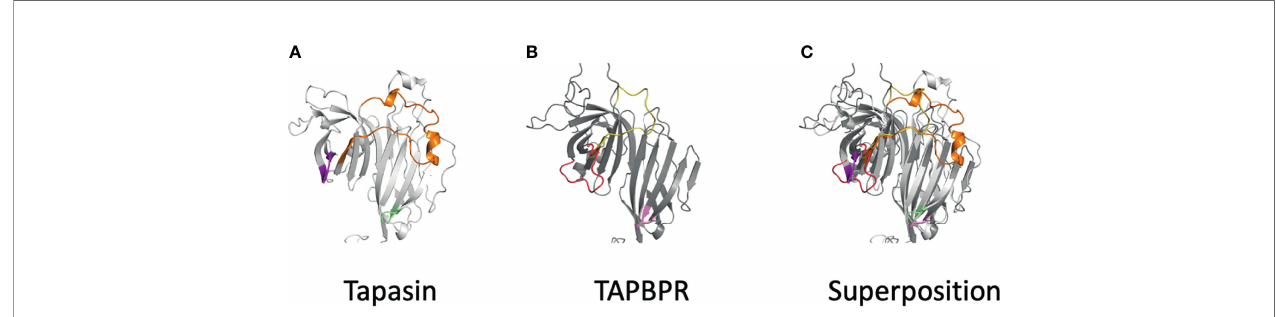
FIGURE 6 | Differences of AlphaFold2 modeled loops of tapasin and TAPBPR suggest distinct details of MHC interactions. (A) Loops of tapasin (E12-L18, magenta), (E72-G101), and (Q189-193, pale green) are shown next to (B) corresponding loops of TAPBPR (D23-D35, red), (E102-A118, yellow), and (Q209-R213). Superposition the two models is shown in